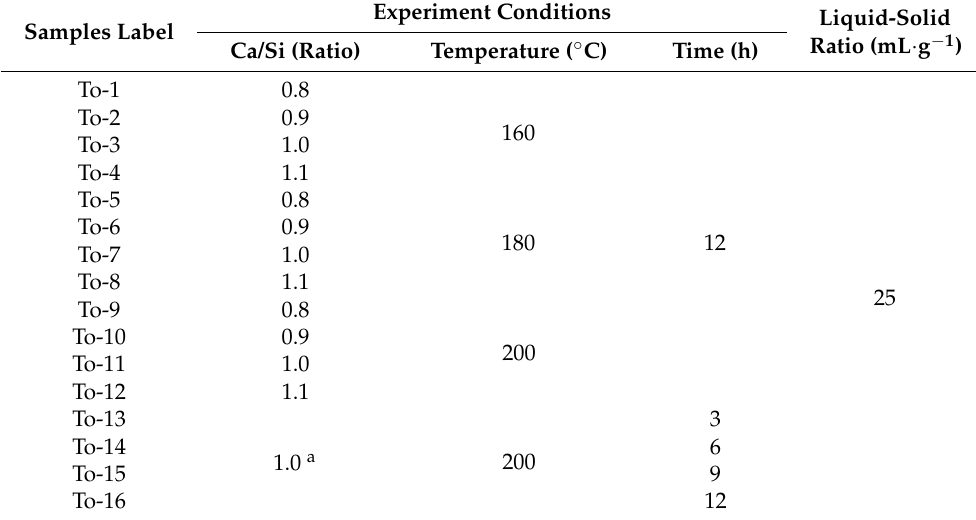
Table 2. Ranges and values of the experimental parameters for 11Å-TA synthesis using AER. Samples